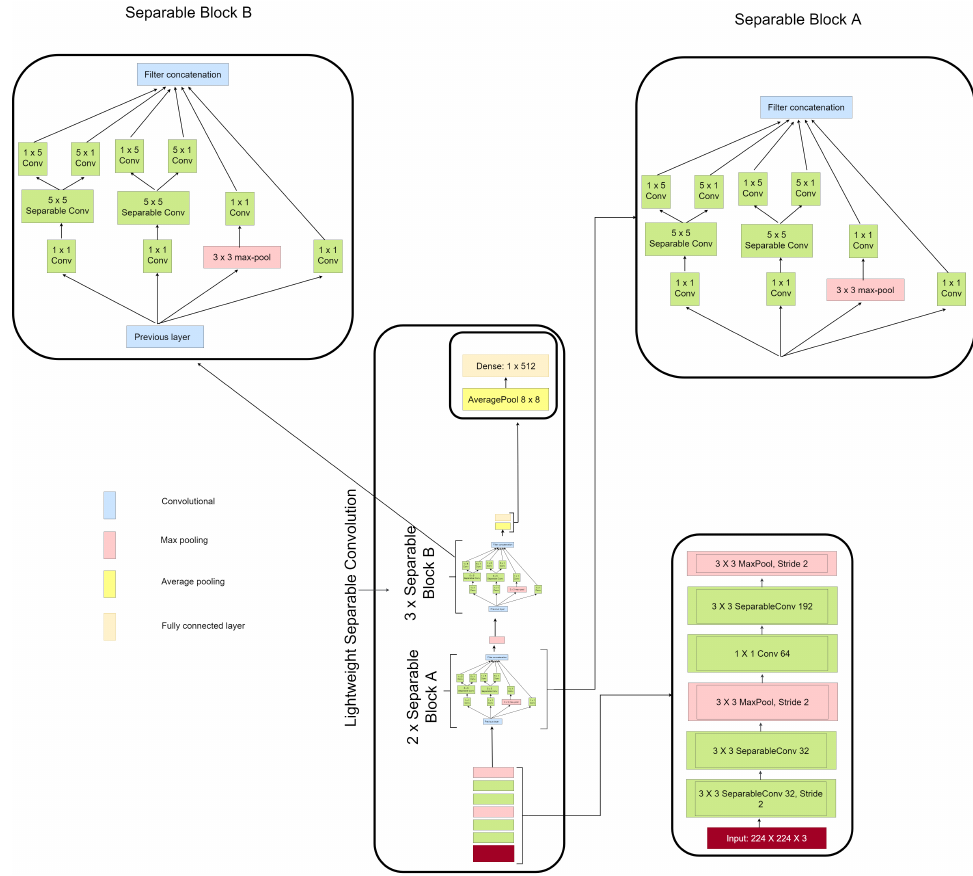
Figure 3. Structure of the lightweight separable